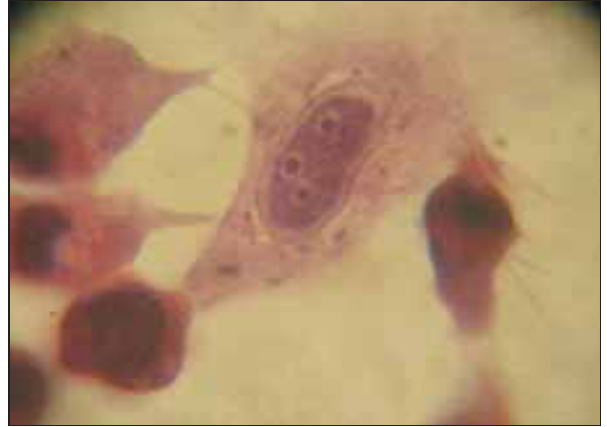
Figure-4: PCR amplification of gC gene of BHV-1 Lane M: 50 bp molecular size marker Lane 1- 4 : 293 bp amplicon of gB region (4 isolates) Lane 5: Negative